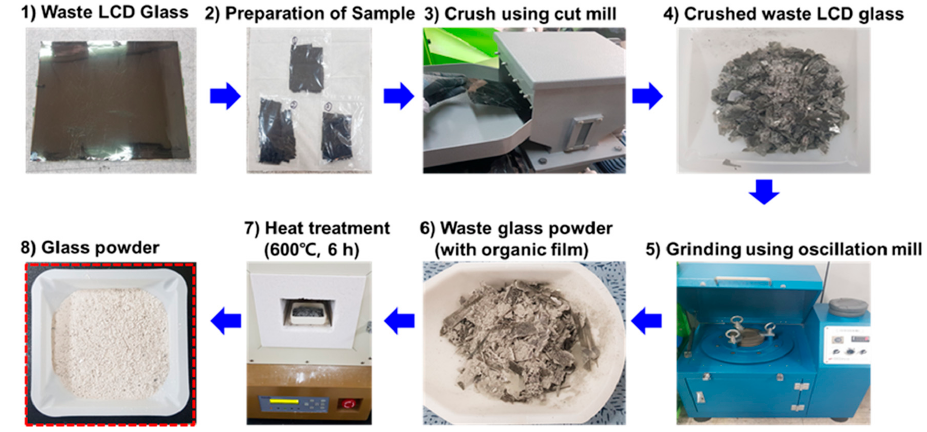
Figure 1. Process chart of waste liquid crystal display (LCD) glass powder.